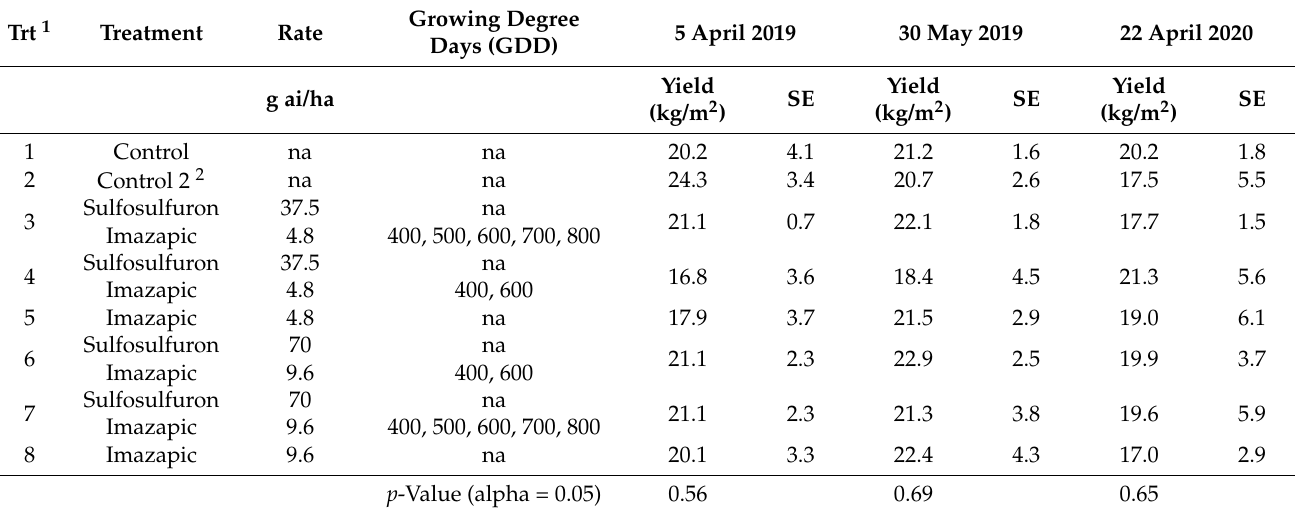
Table 1. Tomato yield from tomato crop safety experiments conducted in 2019 and 2020 in Yolo County, CA, USA.